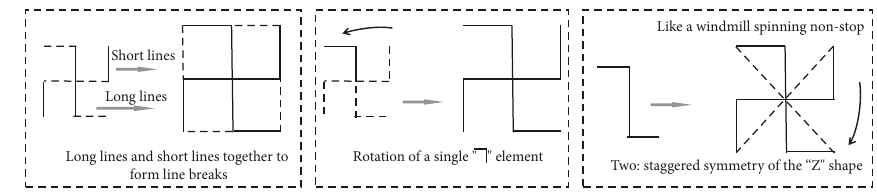
Figure 3: 10,000-character analysis diagram.